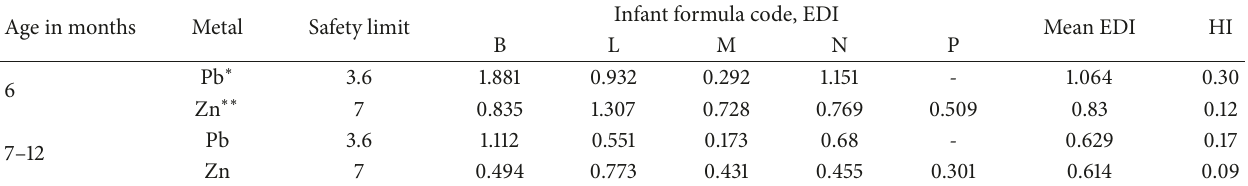
Table 3: The estimated daily intake (EDI) values of metals from commercial infant formulas and the health risk index (HI). Age in